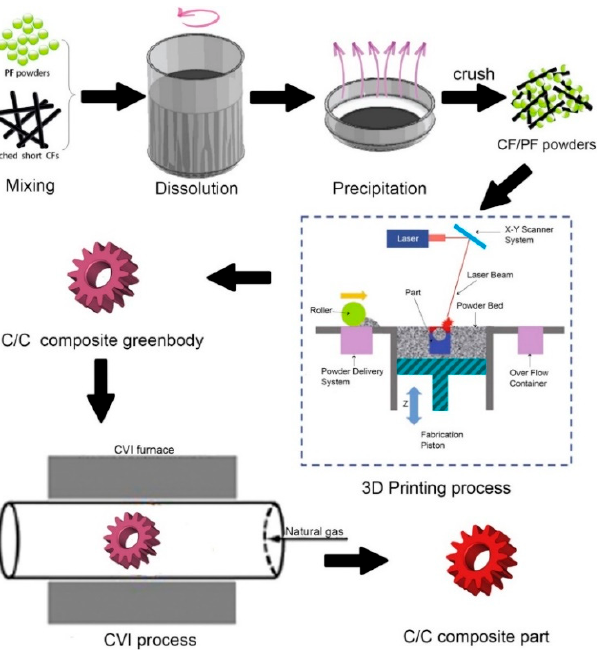
Figure 24. Overview of preparing carbon/carbon composites complex part (adapted with permission from reference [61]).